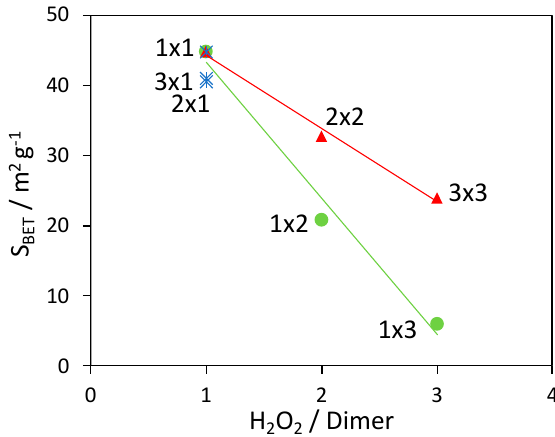
Figure 3. Dependence of the composite surface area vs. the H 2 O 2 /aniline dimer molar ratio: effect of changing the H 2 O 2 amount (green dots), TiO 2 content (blue stars), and of varying both parameters (red triangles). Lines are added as a guide for the eye.